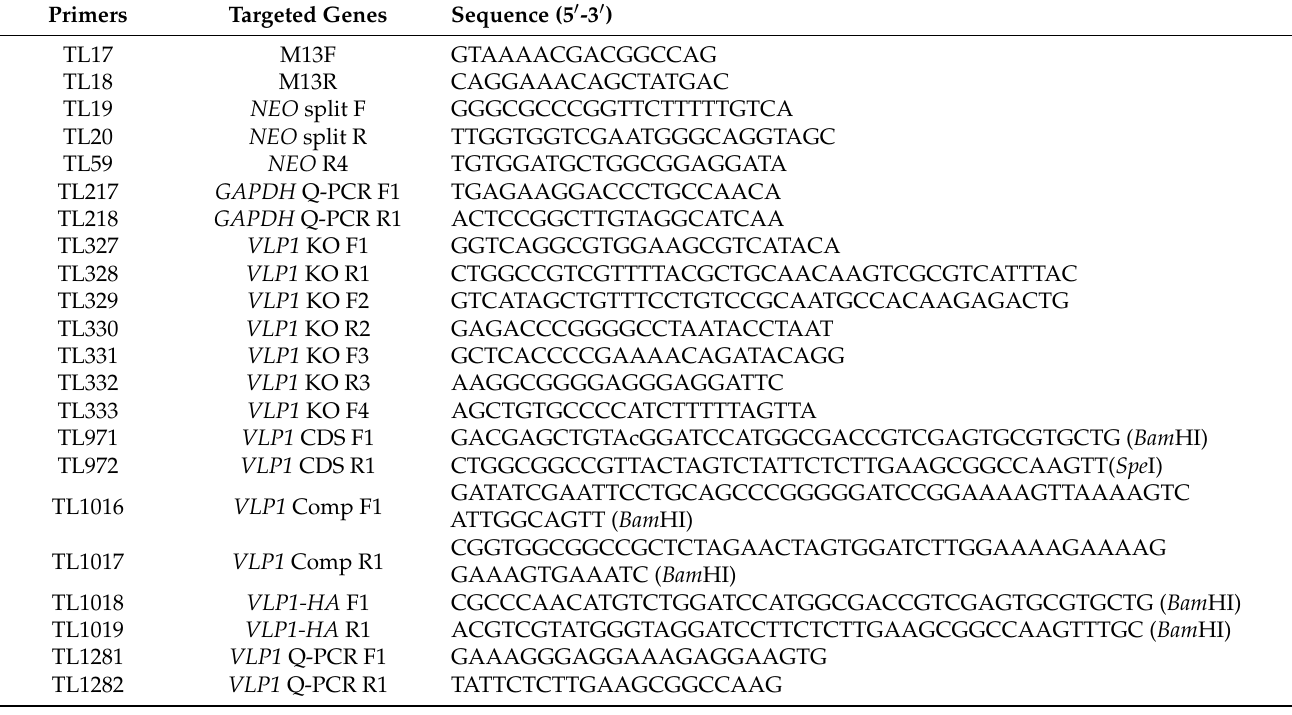
Table 2. PCR primers used in this